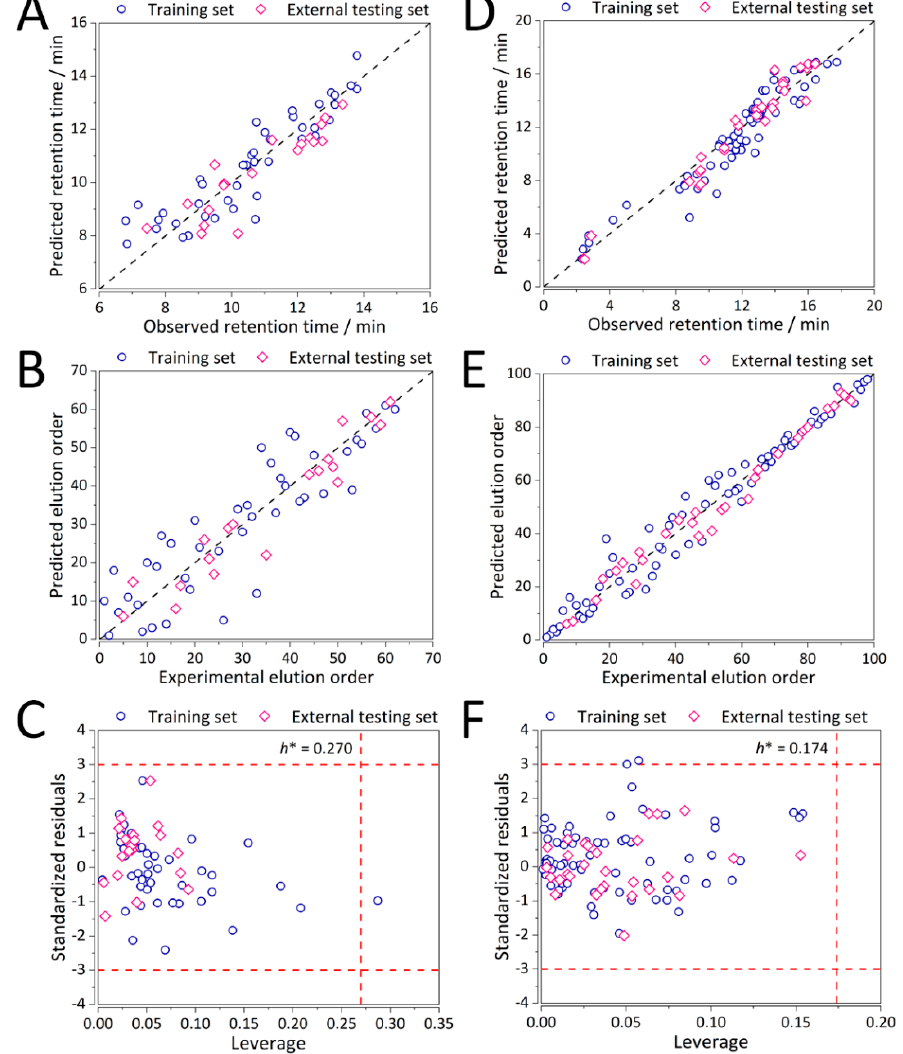
Figure 4. Performance of the MLR-MOO method in prediction of ( A ) retention time, ( B ) elution order, and ( C ) applicability domain for CS1 (Supelcosil LC-18, t G = 10 min, T = 35 °C), ( D ) prediction of retention time, ( E ) elution order, and ( F ) applicability domain for CS2 (Xterra MS C18, t G = 20 min, T = 40 °C). Blue open circle shapes represent the training set, whereas the pink open diamond shapes represent the testing set observations.